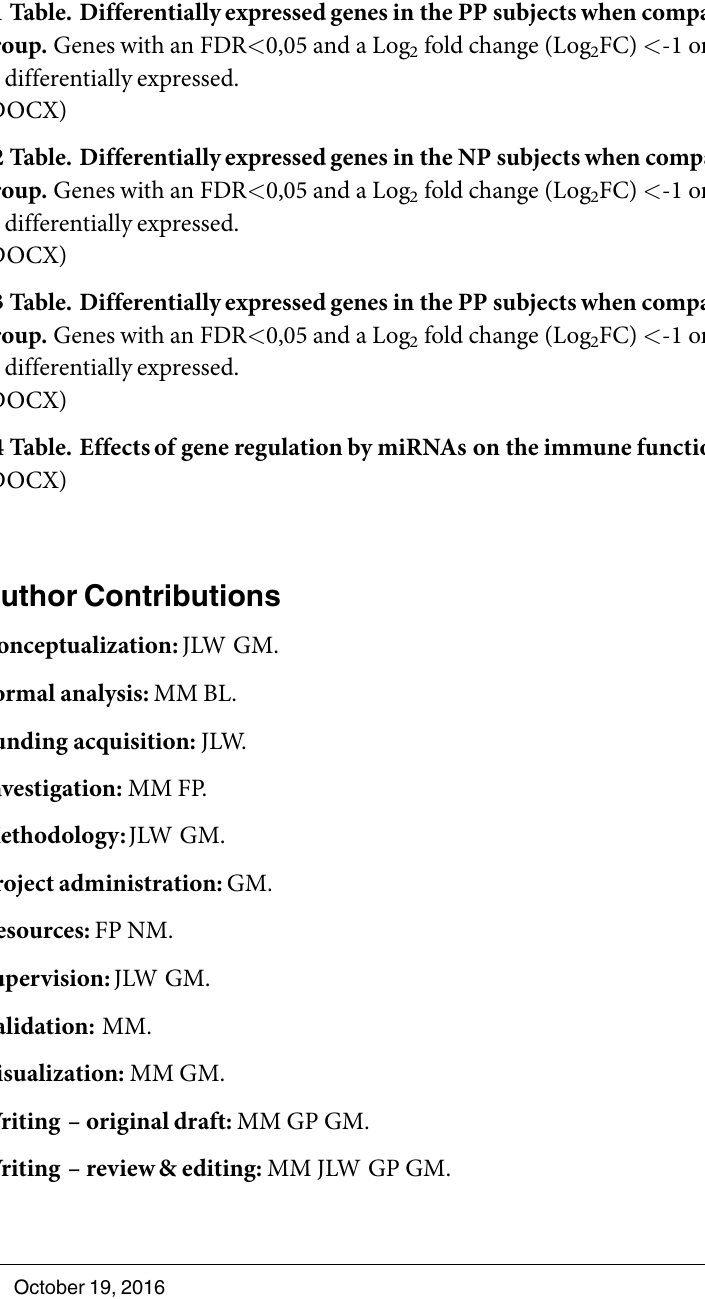
fold change (Log FC) < -1 or > 1 were considered 2 2